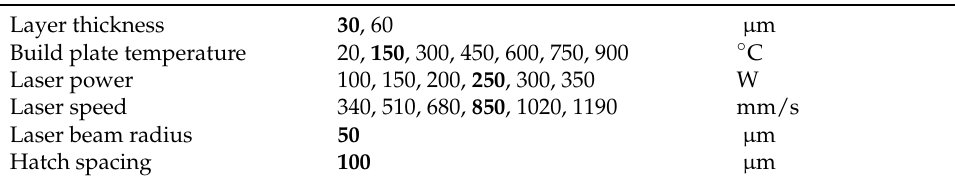
Table 3. Modeled manufacturing parameters.